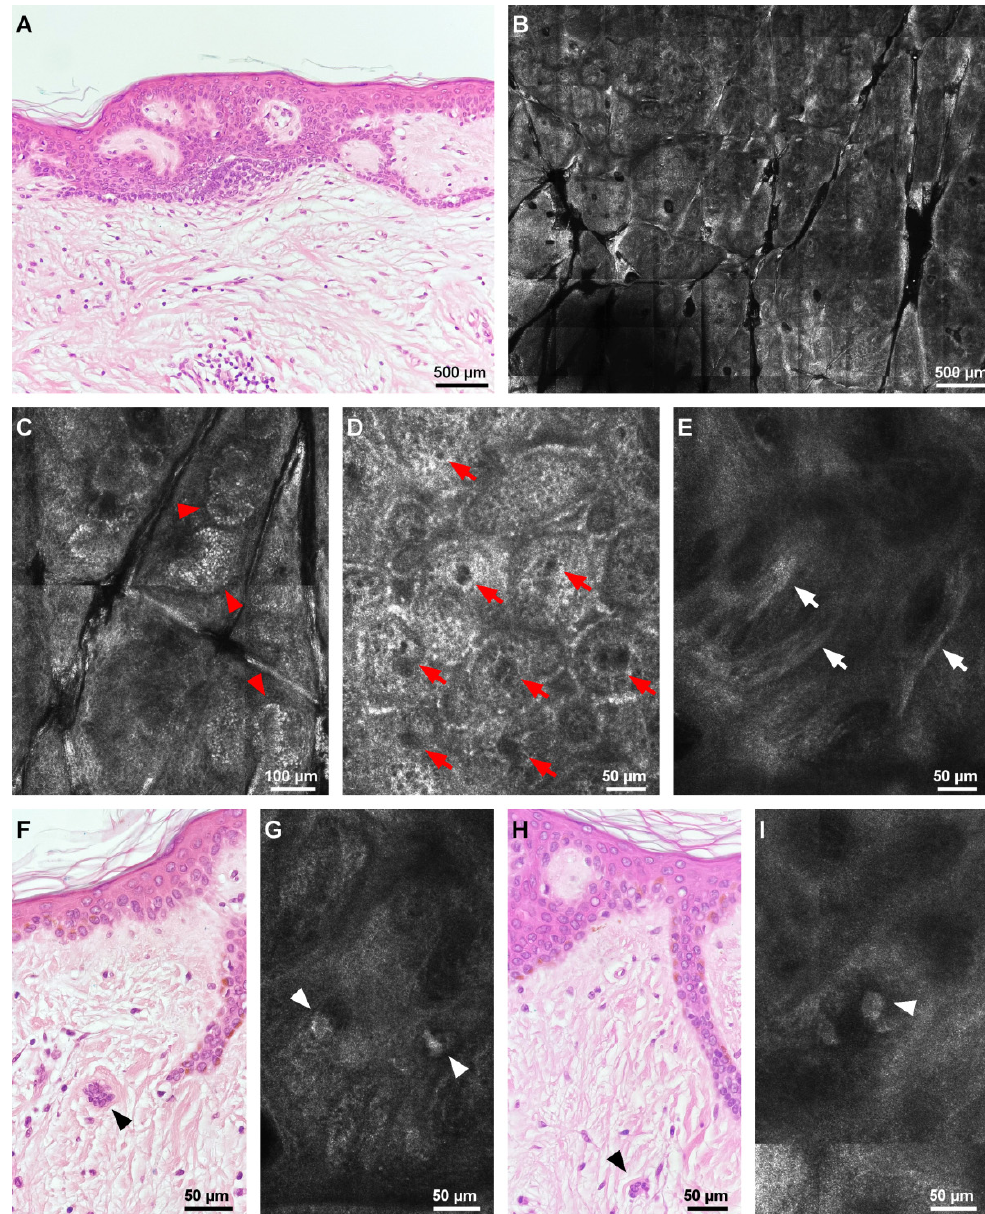
Figure 2. Histopathological and RCM aspects of the lesion. ( A ) Histological architecture of the lesion showing a hyperplastic epidermis, basaloid induction, a proliferation of small vessels, and thickened collagen fibers arranged parallel to the surface, at the level of the reticular dermis (hematoxylin–eosin, 40×). ( B ) RCM mosaic depicting a poorly outlined lesion, presenting with a regular honeycomb pattern and clusters of hyper-reflective cells at the periphery. ( C ) RCM close-up mosaic of the hyper-reflective cells at the periphery (red arrowheads) (correlating histologically to pigmented keratinocytes). ( D ) RCM mosaic showing numerous round, dark spaces at the dermal–epidermal junction (red arrows). ( E ) RCM mosaic at the level of the upper dermis demonstrating hyper-reflective, strand-like structures (white arrows) which correlate to dense collagen bundles parallel to the surface on histology. ( F , H ) Histopathology photomicrographs (hematoxylin–eosin) revealing multinucleated cells (black arrowheads) corresponding on RCM ( G , I ) to mildly reflective, bizarre structures with angulated edges (white arrowheads).